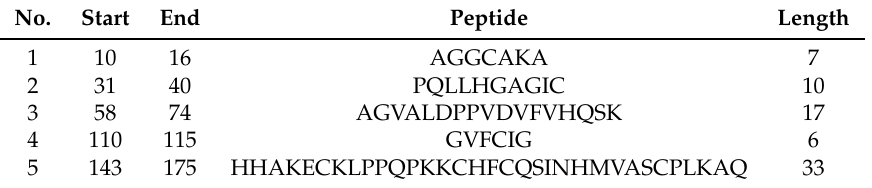
Table 4. Predicted antigenic peptides using the Kolaskar and Tongaonkar antigenicity method. No.